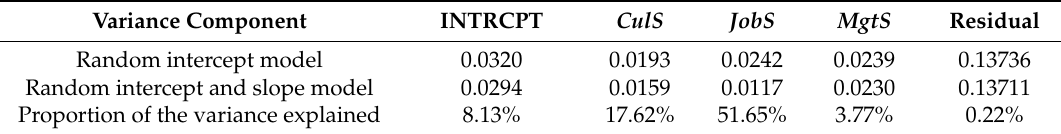
Table 4. Effect of the two-level HLM on the model with fixed and random